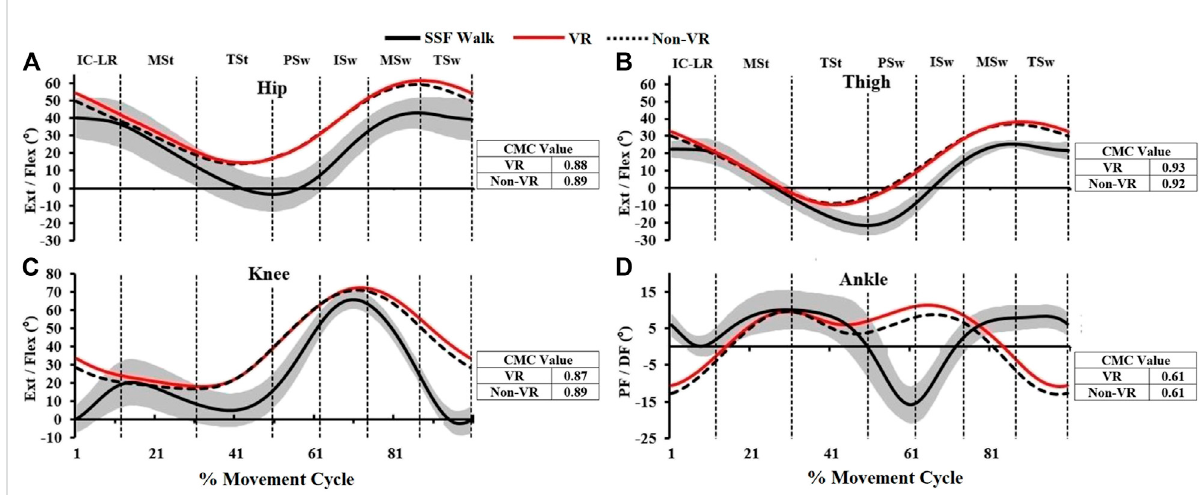
FIGURE 2 Theensemblesagittalplanejointkinematics(degrees)ofhip,thigh,knee,andankle (A – D) ofthisstudywhichinclude1)fastovergroundwalking (SSF Walk; black line = mean; gray band = ± one standard deviation), 2) exercise while overriding motor ’ s assistance with VR (solid red line) and withoutVRgaming(dashedline).Thecoef fi cientofmultiplecorrelation(CMC)representsjointkinematicsimilaritybetweenVR/Non-VRvs.SSFWalk, respectively (IC: Initial Contact, LR: Loading Response, MSt: Mid Stance, TSt: Terminal Stance, PSw: Pre-Swing, ISw: Initial Swing, MSw: Mid Swing, TSw: Terminal